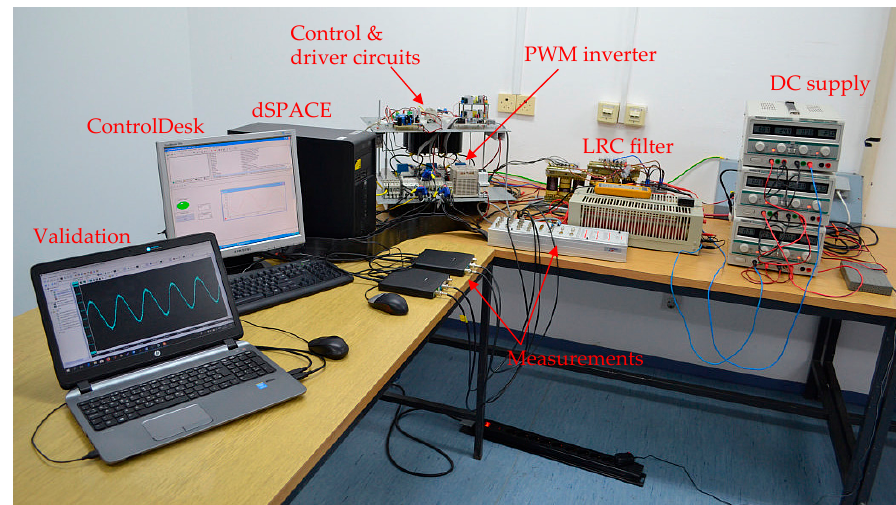
Figure 6. Laboratory testbed for distorted voltage generation.